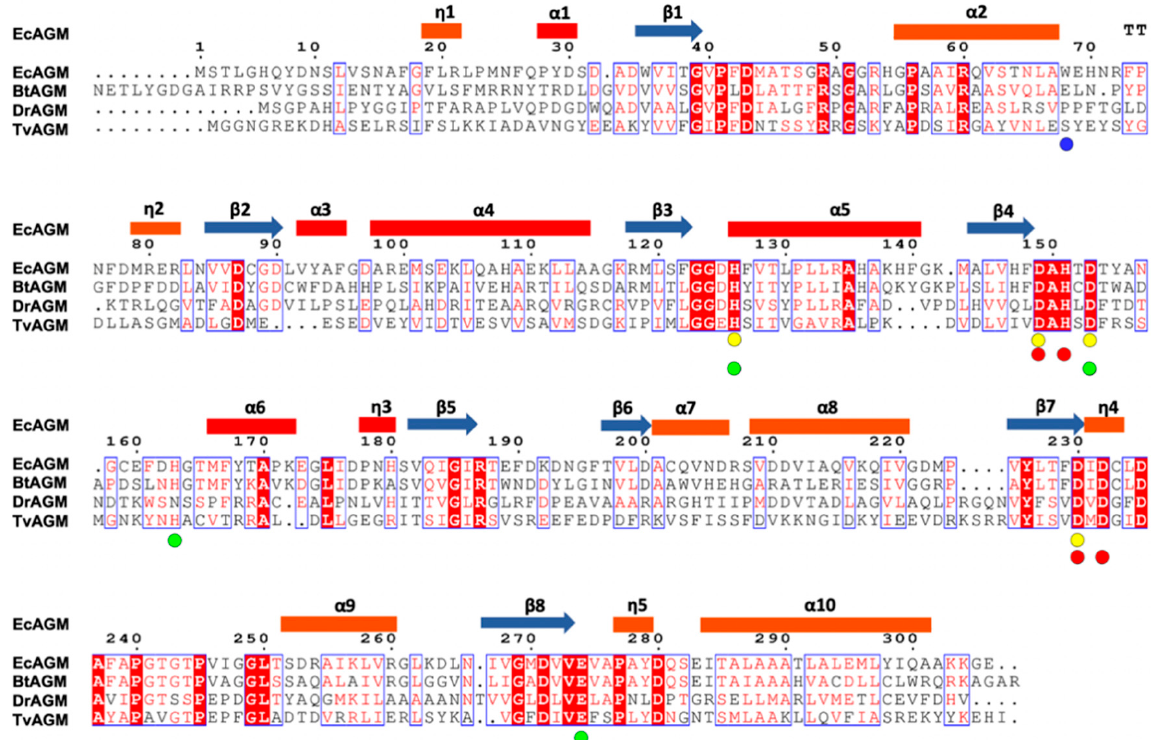
Figure 3. Sequence alignment of agmatinases from EcAGM, Burkholderia thailandensis (BtAGM), Deinococcus radiodurans (DrAGM), and Thermoplasma volcanium (TvAGM). With circles are indicated the amino acids implicated in the interaction with the Mna (yellow) and Mnb (red), respectively. In green circles are indicated the amino acids implicated in urea and guanidine binding. In blue is indicated the Trp68 in EcAGM.